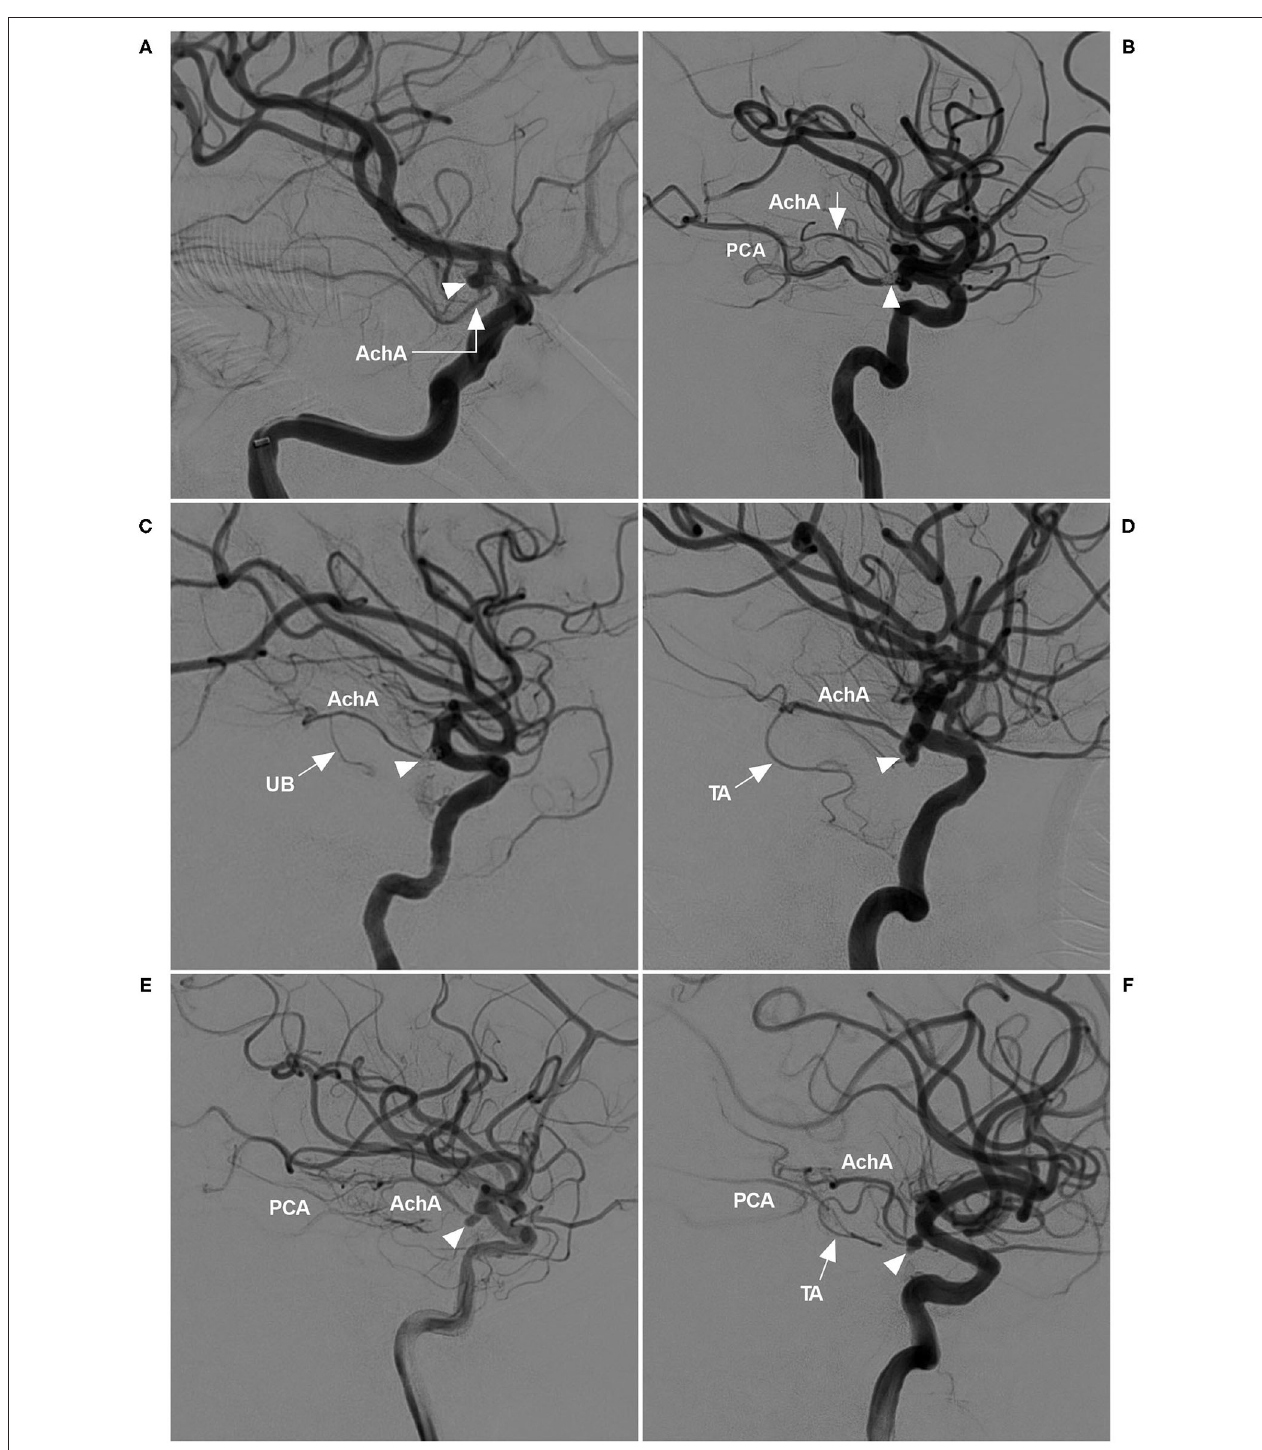
FIGURE 1 | AchA anatomy in cases with aneurysm. (A) DSA showing a single-trunk AchA (right-angled arrow) with an aneurysm (triangle) at its origin. (B) DSA showing the AchA consisting of a plexus of vessels with a coiled aneurysm (triangle) at its origin. In this plexus, a major branch (arrow) was prominent; moreover, PCA was the fetal type. (C) DSA showing a large AchA with a coiled aneurysm (triangle), in which an uncal branch (UB, arrow) could be seen. (D) DSA showing a large AchA with an aneurysm (triangle), in which a temporal artery (TA, arrow) could be seen. (E) DSA showing a large AchA with an aneurysm (triangle). The AchA anastomoses with the PCA. (F) DSA showing a large AchA with an aneurysm (triangle). The AchA sent out a large temporal artery (TA, arrow) and anastomosed with the PCA. AchA, anterior choroidal artery; DSA, digital subtraction angiography; PCA, posterior cerebral artery; TA, temporal artery; UB, uncal branch.